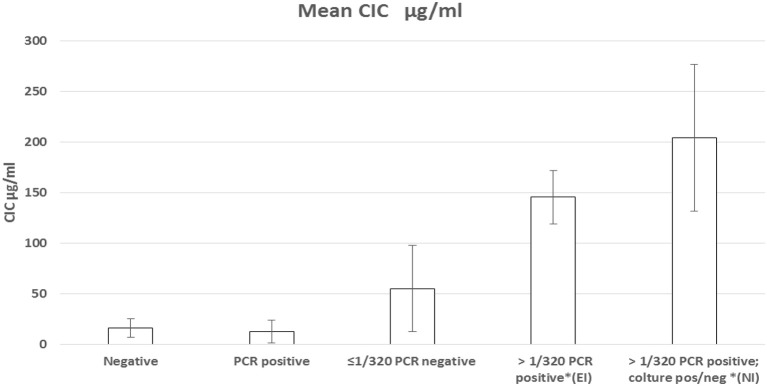
Graphical representation of CICs serum level.